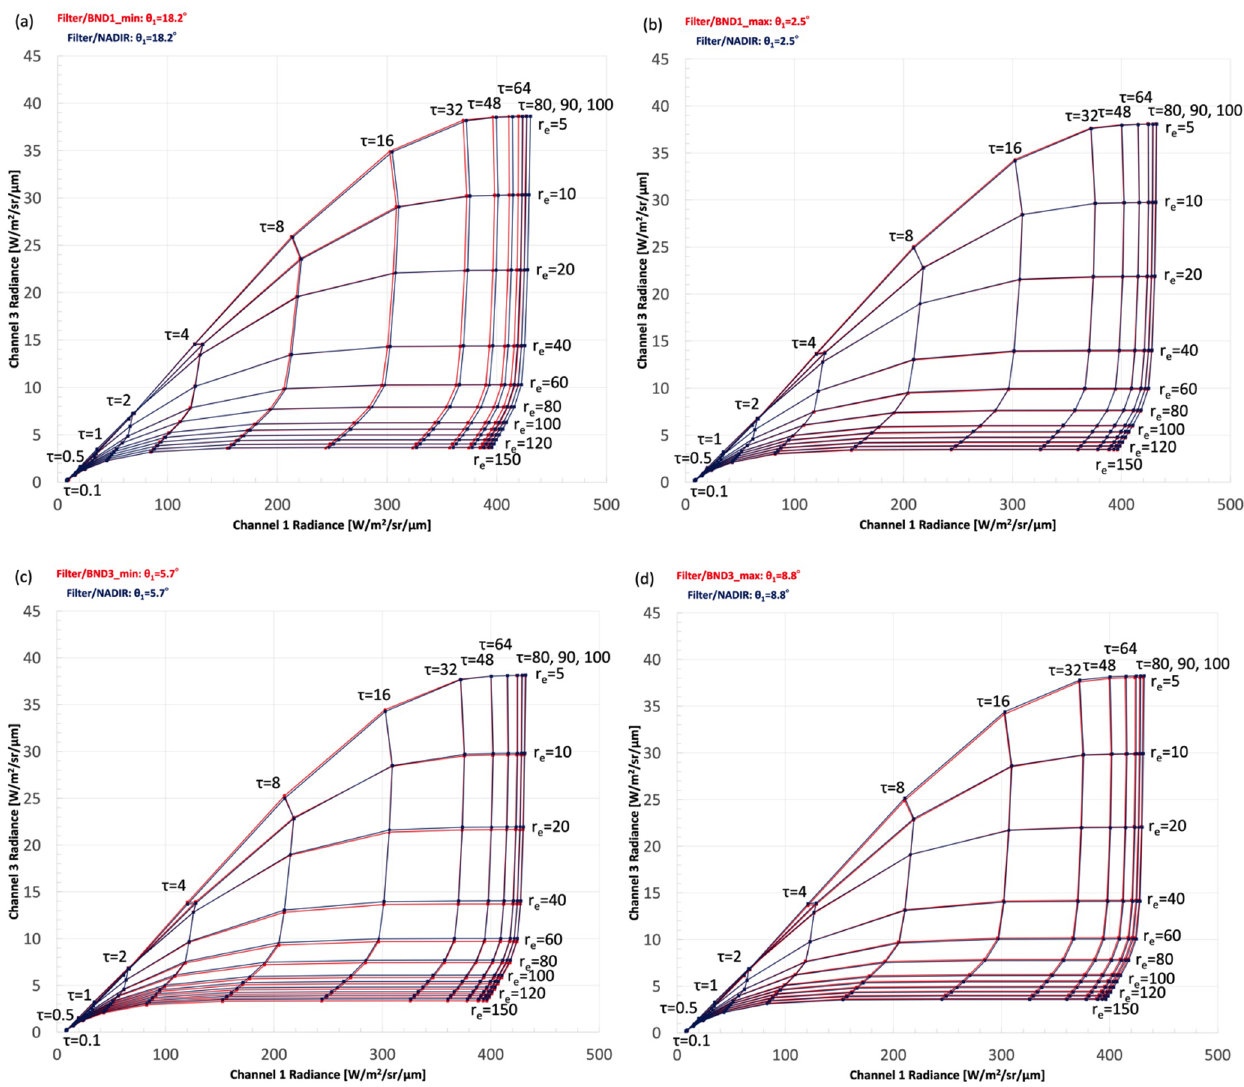
Figure 6. Nakajima–King diagrams for deep convective clouds at (a) pix_BND1_min, (b) pix_BND1_max, (c) pix_BND3_min, and (d) pix_BND3_max for a solar zenith angle of 20 ◦ . The red lines show the results from the response function with SMILE. The black lines show the results from the nadir response function.